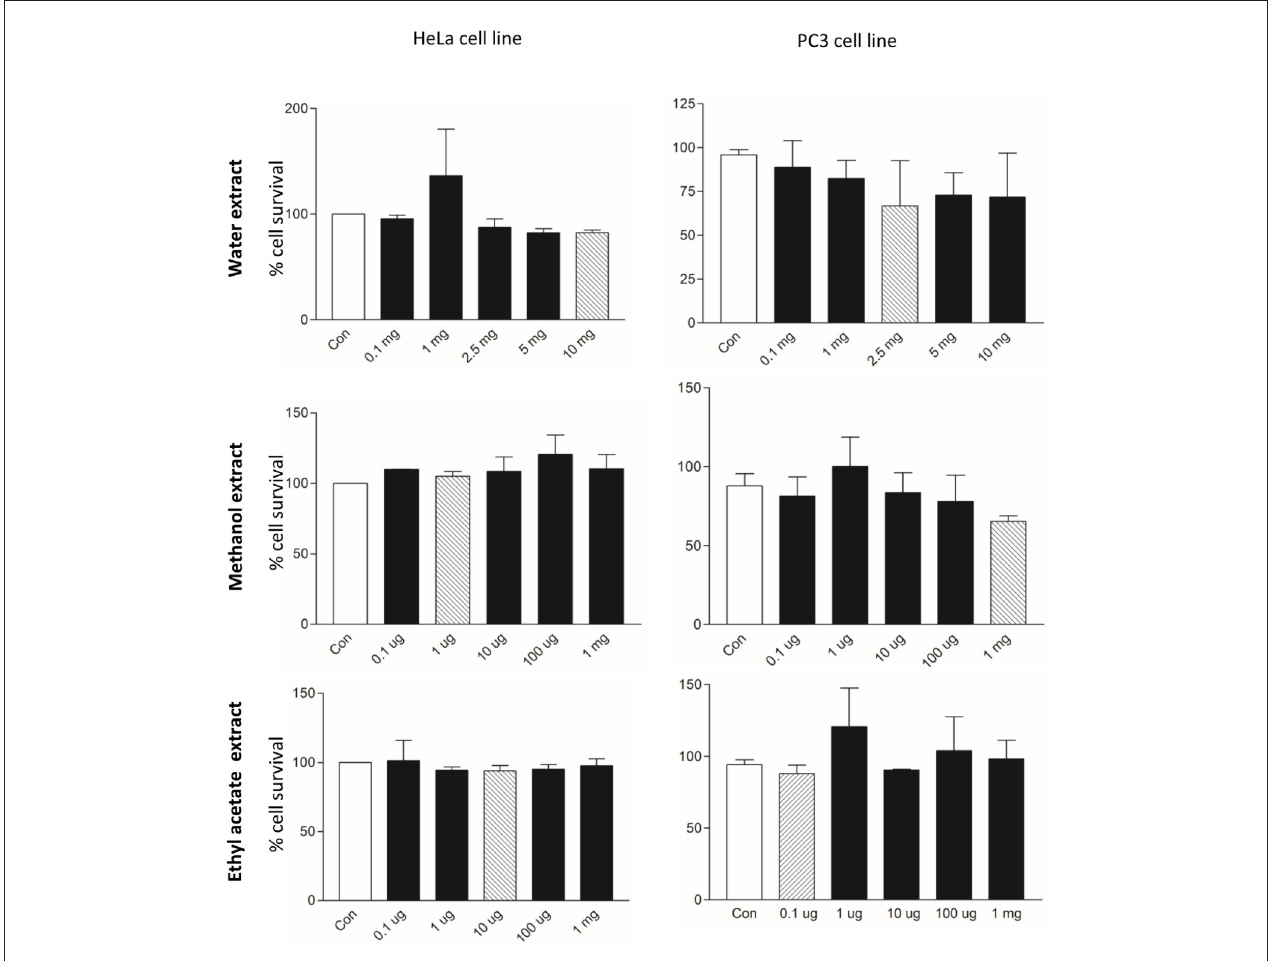
FIGURE 7 | Cell viability assay (MTT) analysis of HeLA and PC3 cancer cell lines after application of different extracts of Ononis natrix. White bars and striped bars indicate controls and significantly different applications, respectively.